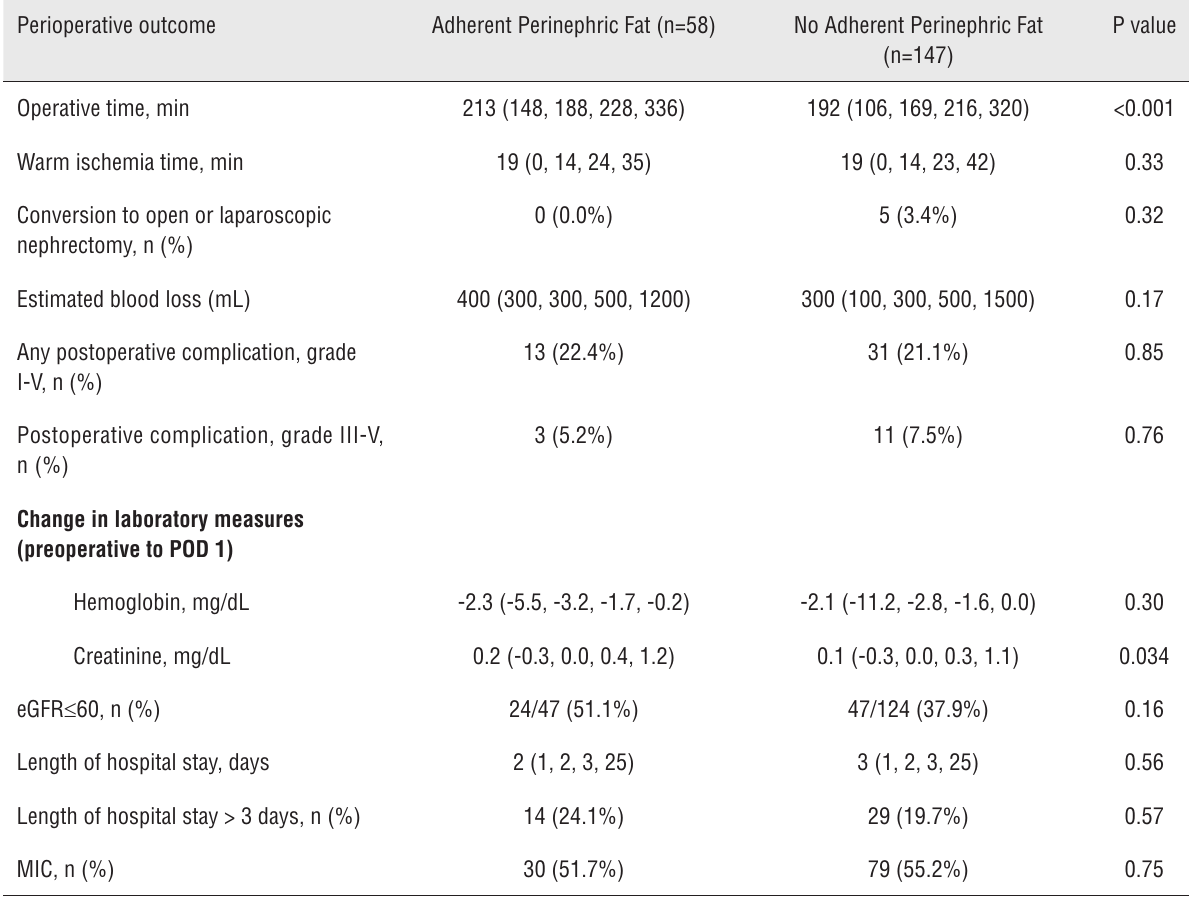
Table 1 - Patient and renal mass characteristics. Table 2 - Comparisons of perioperative outcomes according to presence of adherent perinephric fat. Perioperative